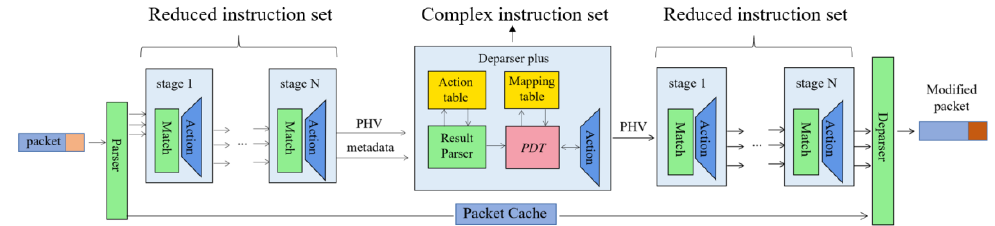
Figure 1. Overall architecture of programmable SRv6 processor.